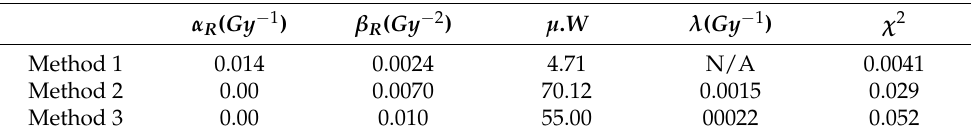
Table 4. Parameter values in the bystander effect simulation model for MM576 cells [21]. Source of the experimental data: